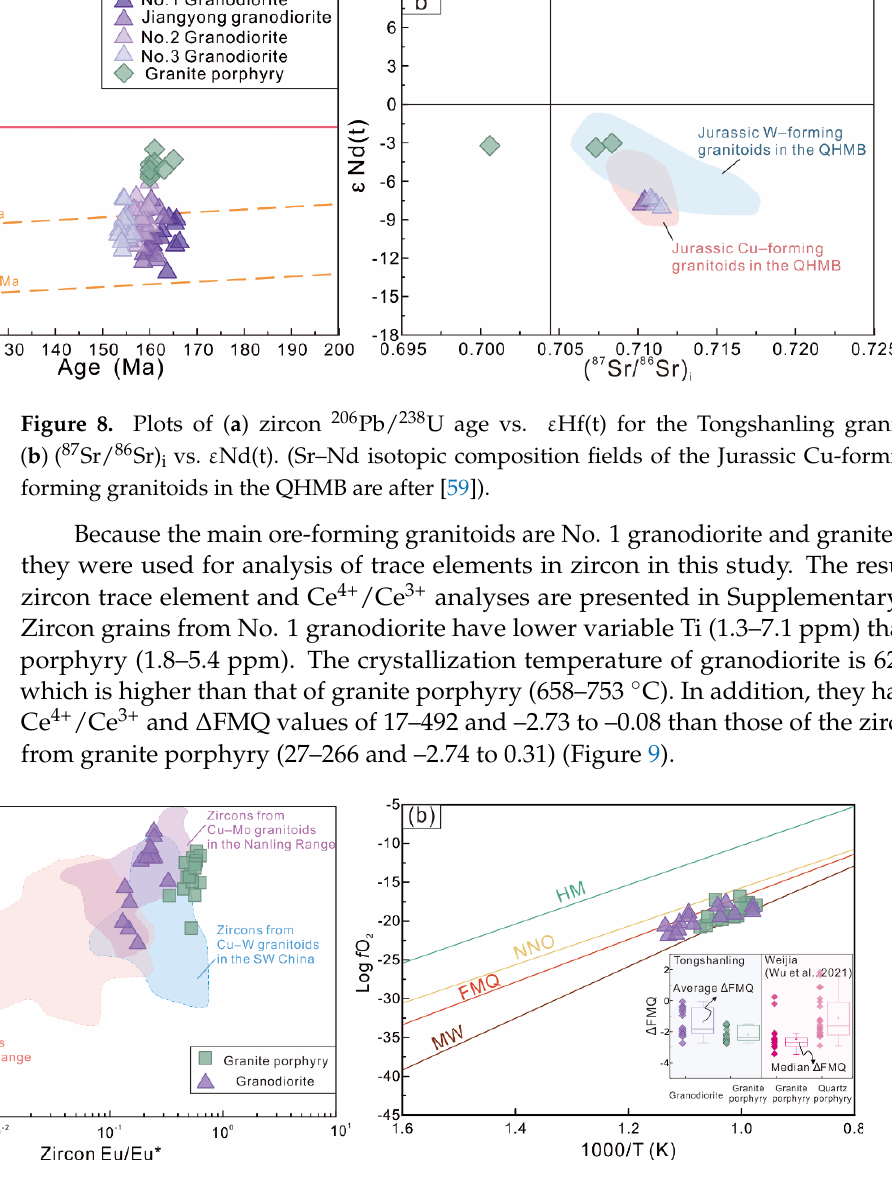
Figure 9. Plots of ( a ) zircon Eu/Eu* vs. zircon Ce 4+ /Ce 3+ , and ( b ) 1000/T vs. log f O 2 . Zircon data of Nanling Sn–W granitoids came from [13]; zircon data of Nanling Cu–W granitoids came from [9]; zircon data for Cu–Mo granitoids in SW China came from [7]; zircon data of Weijia granitoids came from [35].